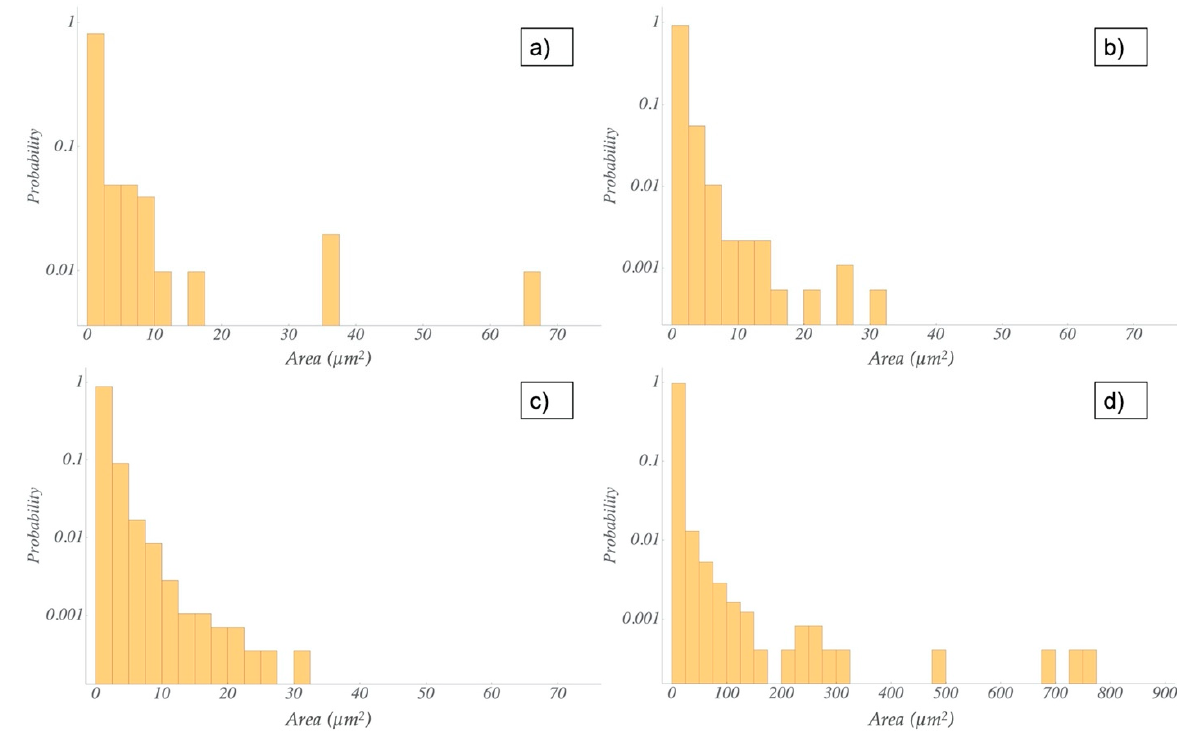
Figure 4. Comparison of different nanofiller dispersed in resin (TRM): ( a ) 0.5 wt% CNF; ( b ) 0.5 wt% CNToxi; ( c ) 0.5 wt% CNT; ( d ) 0.5 wt% CNT semi-dispersed.